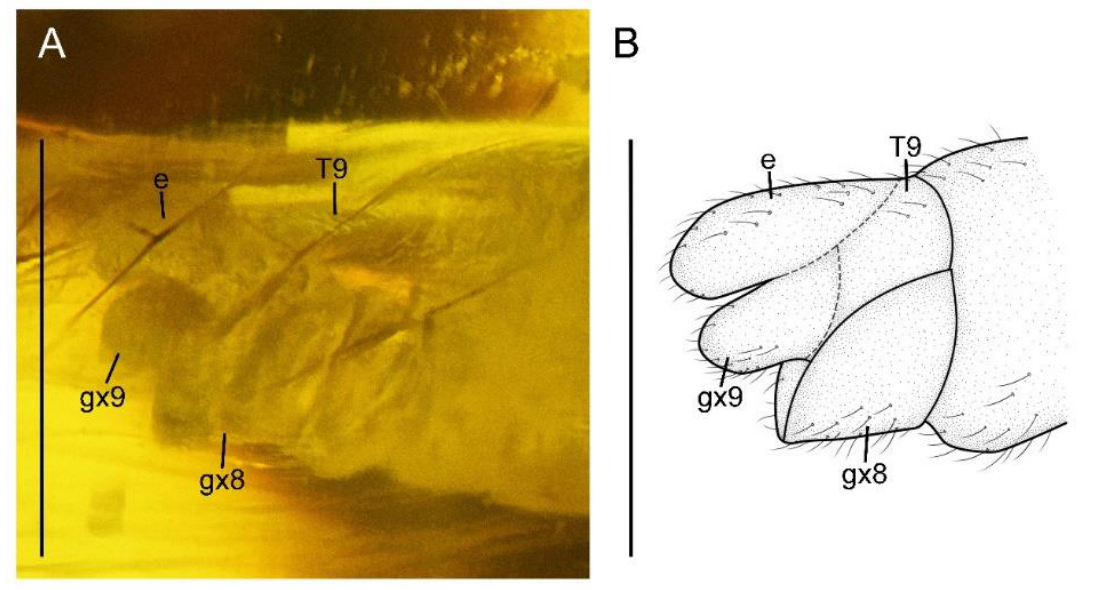
Figure 3. Paradoxoconis szirakii gen. et sp. nov. , holotype: NIGP 180659, drawings of wing venation. ( A ) Right forewing, with partial reconstruction; ( B ) right hind wing, with partial reconstruction; ( C ) right hind wing; ( D ) right hind wing, with partial reconstruction. Scale bar = 1.0 mm.